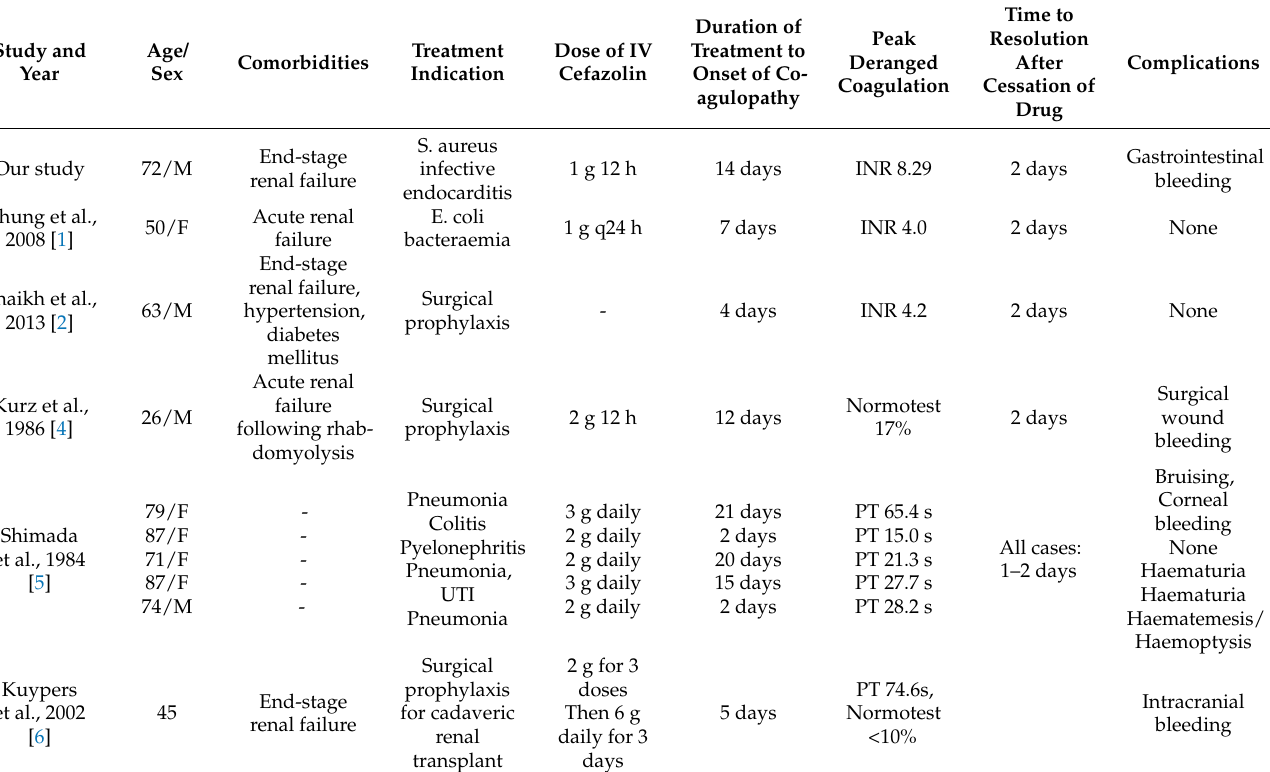
Table 1. Summary of prior case reports on cefazolin-related deranged